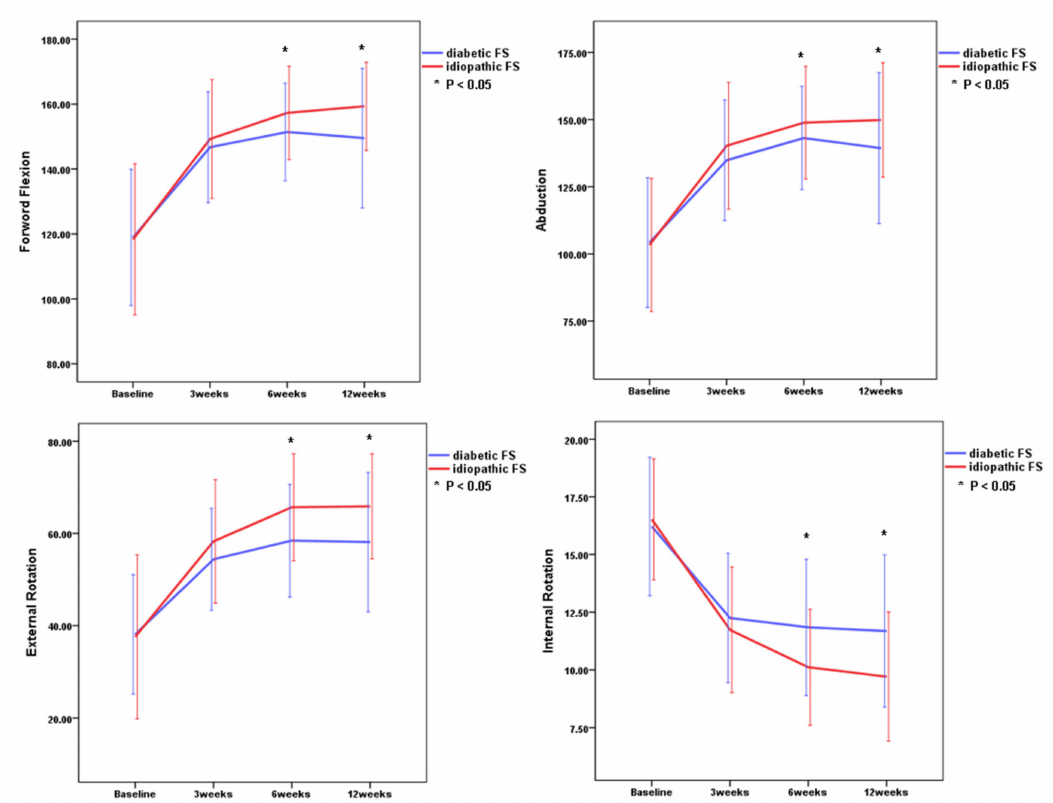
Figure 2. Comparison of range of motion between the two groups. Internal rotation was recorded on the basis of the vertebral level reached with the tip of the thumb. Asterisk indicates significant di ff erences between the idiopathic frozen shoulder group and the diabetic frozen shoulder group at each time point. Error bar means one standard deviation. Table3. Statisticalanalysis of outcomemeasurementsat eachpoint forpatients withdiabetic oridiopathic FS. VAS ASES SSV FF ABD ER IR Baseline 0.276 0.698 0.546 0.933 0.747 0.706